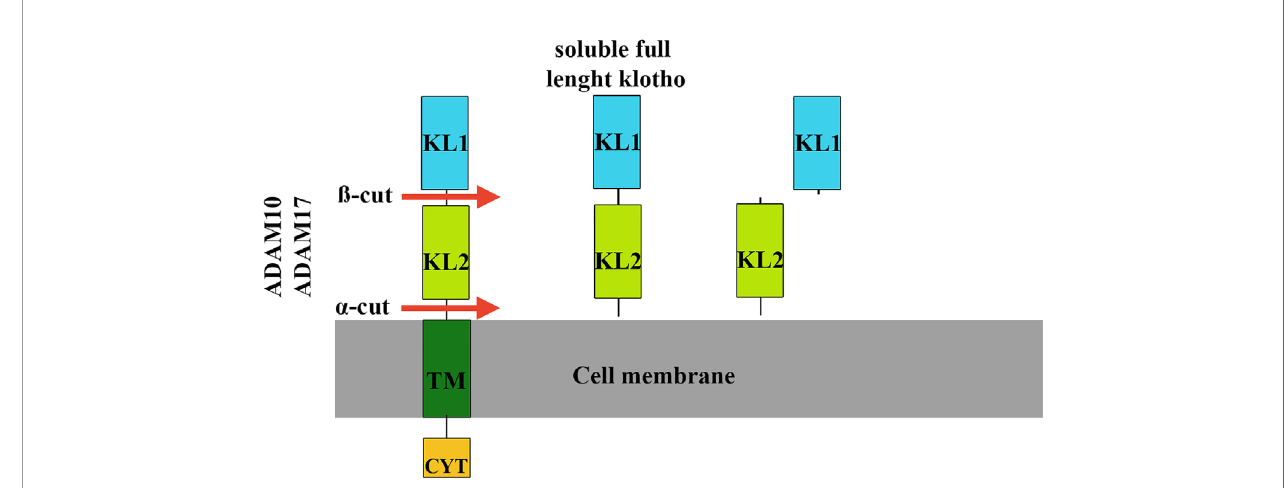
FIGURE 6 | Klotho cleavage mechanisms. Klotho cleavage occurs in the extracellular domain of the klotho protein and is carried out by proteases (ADAM10 and ADAM17). In kidney cells, cleavage at a site directly above the cell membrane ( a -cut) results in full-length circulating soluble klotho, which can act in many different organs and tissues. The other type of cleavage (ß-cut) occurs between the KL1 and KL2 domains that give rise to the KL2 and KL1 fragments. TM, membrane portion of klotho. CYT, intracellular portion of